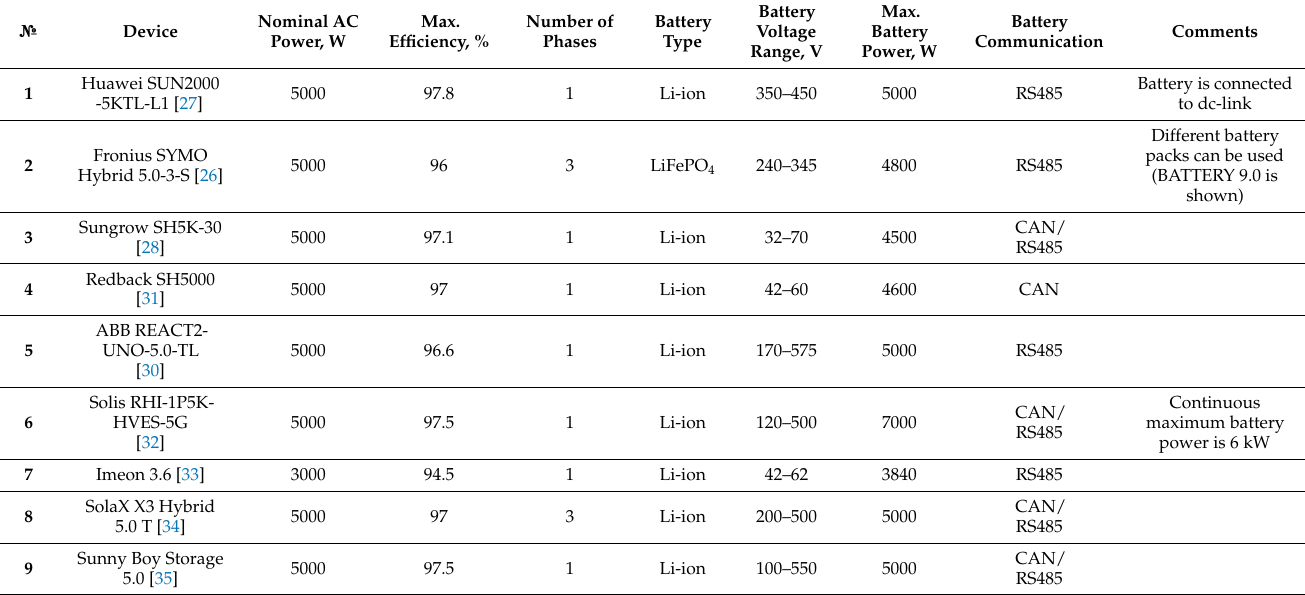
Table 1. Table of commercial hybrid